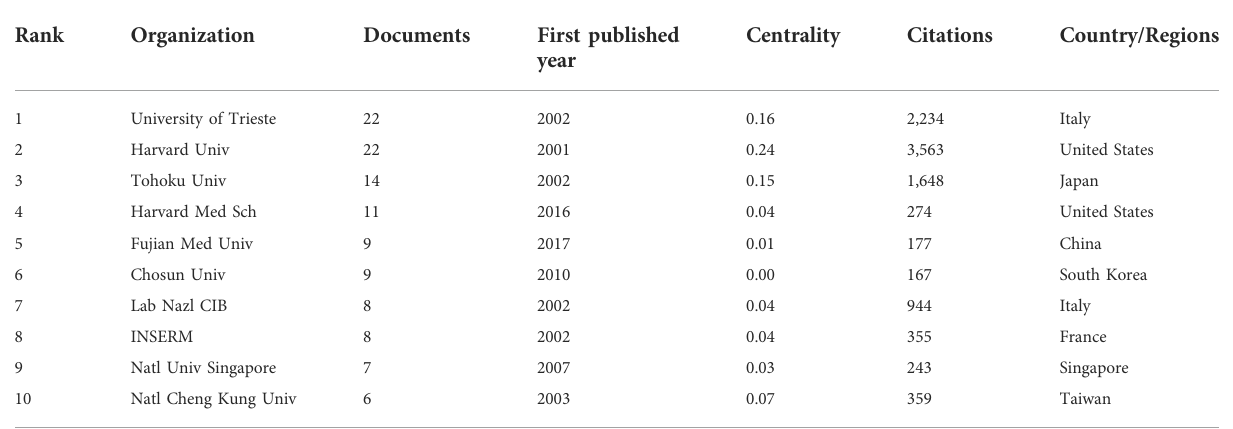
TABLE 2 Top 10 most productive